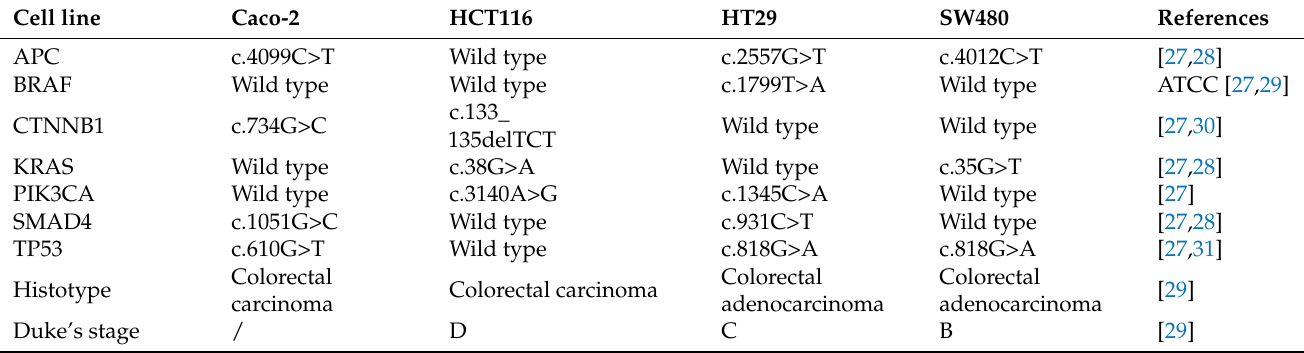
Table 1. Colorectal cancer cell lines, genetic background and